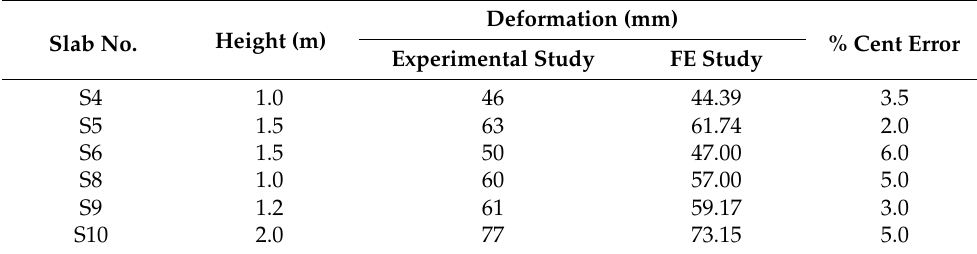
Table 3. Comparison of results of properties of reinforced steel.